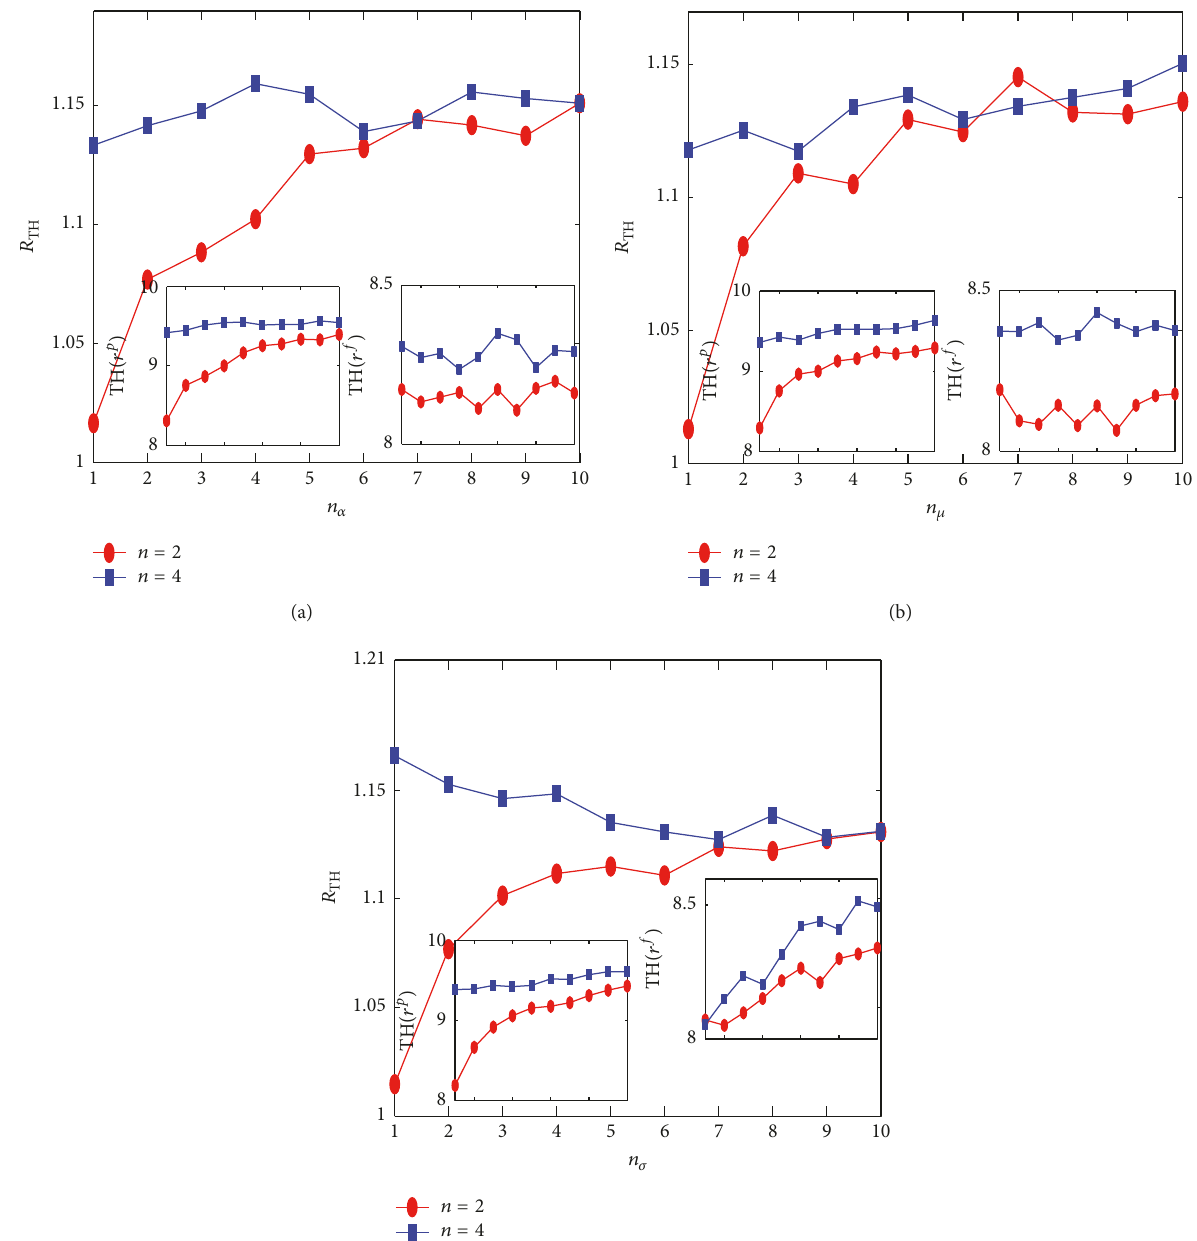
Figure 4: Uncertainty and relative uncertainty against changes of different information characteristics of common factors.